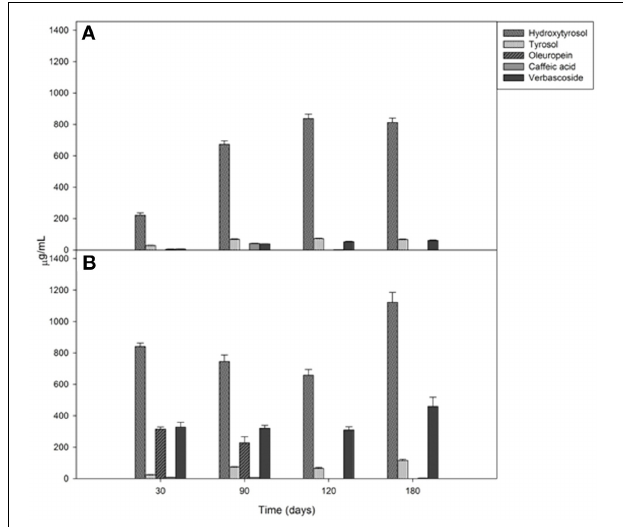
FIGURE 4 | Mono and polyphenol compound concentrations in Cellina di Nardò (A) and Leccino (B) brines during natural fermentation